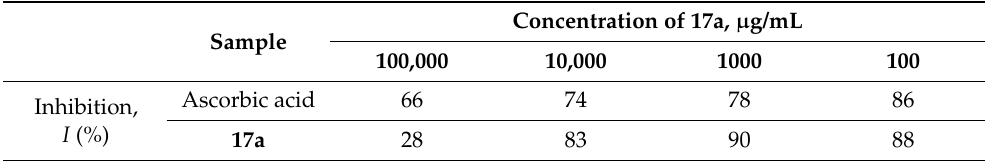
Table 2. Percentage of free radical inhibition of 17a against DPPH compared with the control (ascorbic